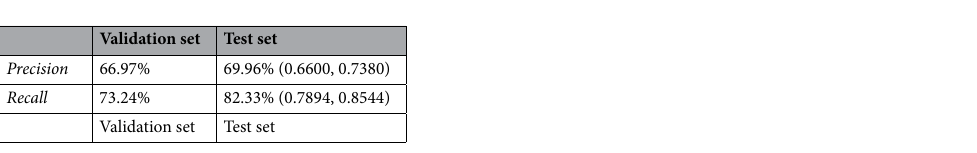
Table 1. Classification